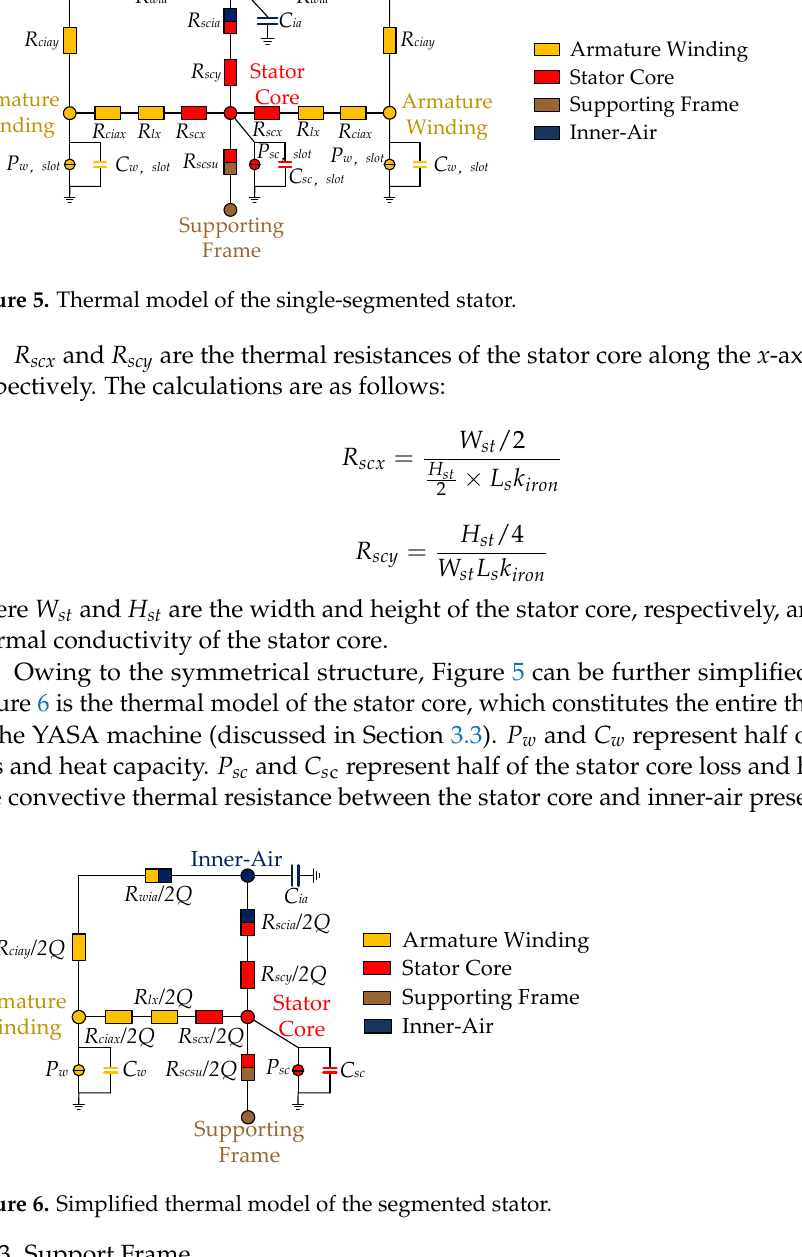
( b ) Figure 7. Stator: ( a ) segmented stator core; ( b ) stator core and cages. The thermal model of the support frame is shown in Figure 8. The support frame connects with the stator core and shaft. The thermal resistance between the support frame and stator core is R scsu , as shown in Figure 6. The thermal resistance between the support frame and shaft is R sush . In addition, there is thermal resistance R suia between the support frame and inner-air. The calculation equations follow: 𝑅 𝑠𝑐𝑠𝑢 = (13) where l scsu is the tolerance clearance between the support frame and stator core, l sush is the tolerance clearance between the support frame and shaft, S scsu is the area of the tolerance clearance between the support frame and stator core, S sush is the area of the tolerance clear- ance between the support frame and shaft, and k air is the thermal conductivity of air. R sui and H su are the inner radius and height of the connector. Supporting Frame Shaft Supporting Frame Inner-Air Figure 8. The thermal model of the support frame.